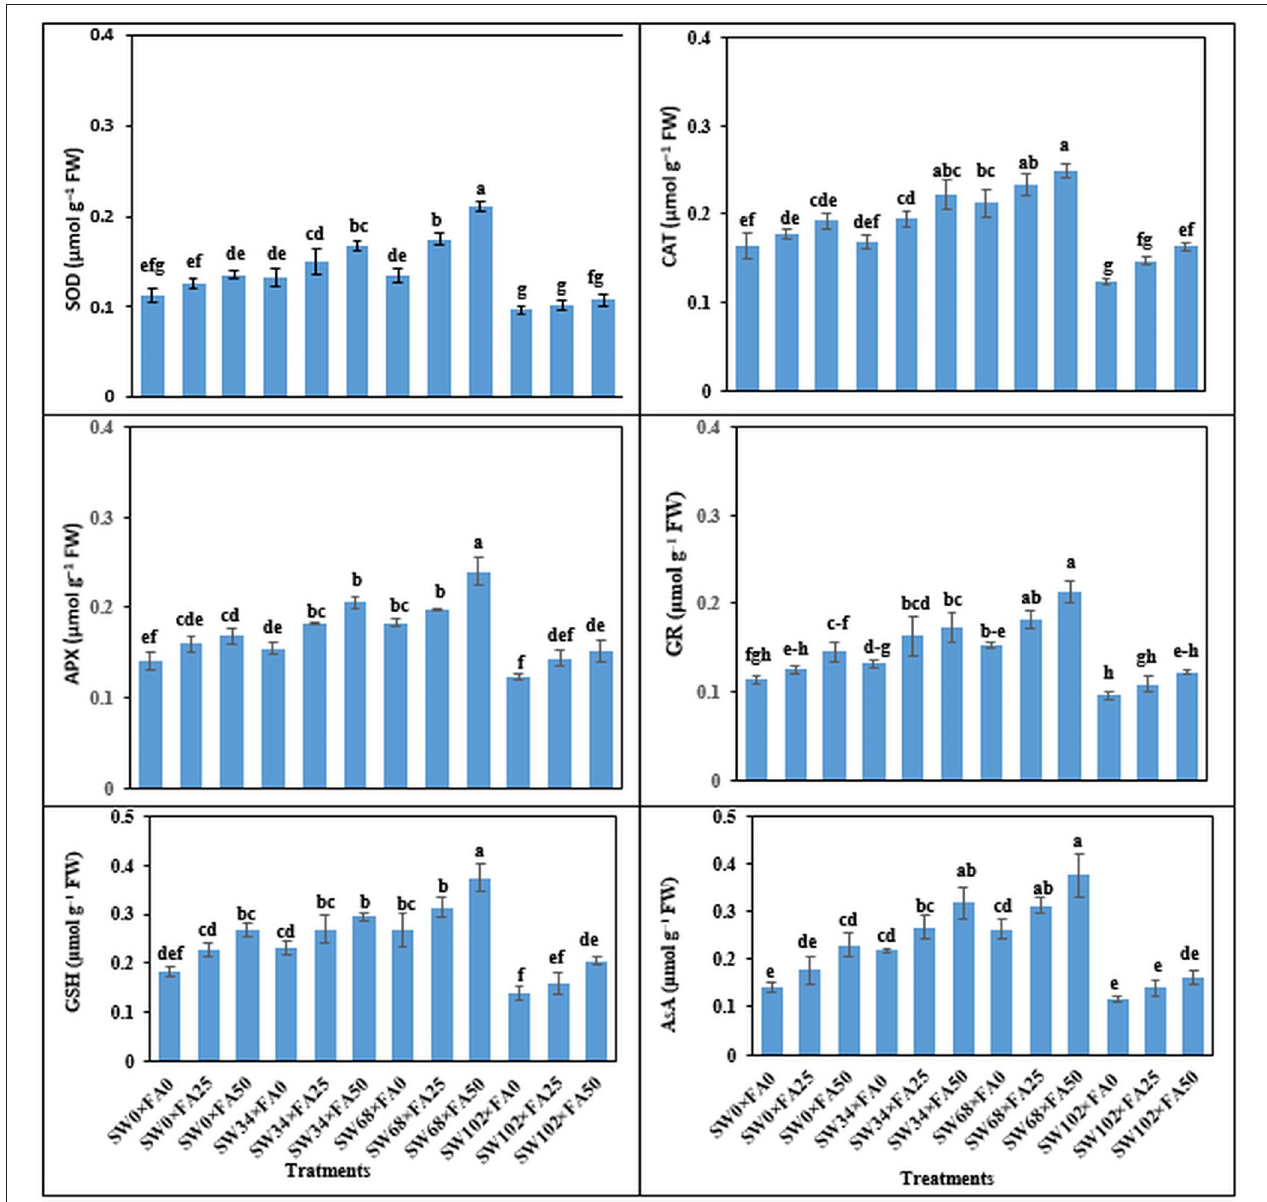
FIGURE 2 | The interactive effect of folic acid (FA) and saline water (SW) on enzymatic antioxidant activity of Plectranthus amboinicus . (A) SOD; (B) CAT; (C) APX; (D) GR; (E) GSH; and (F) AsA activity of P. amboinicus the two seasons of 2018/2019 and 2019/2020. Different letters on the bars refer to significant differences among means based on Fisher’s least-significant difference test at p < 0.05. SOD, superoxide dismutase; CAT, catalase; APX, ascorbate peroxidase; GR, glutathione reductase; GSH, glutathione; AsA, ascorbic acid; SW0, 0mM NaCl; SW34, 34mM NaCl; SW68, 68mM NaCl; SW102, 102mM NaCl; FA0, 0 µ M FA; FA 25, 25 µ M FA; FA50, 50 µ M